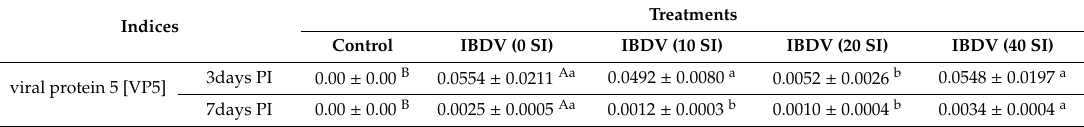
Table 6. E ff ect of adding soy isoflavones on the IBDV mRNA expression of bursal tissue in IBDV—challenged broilers 1